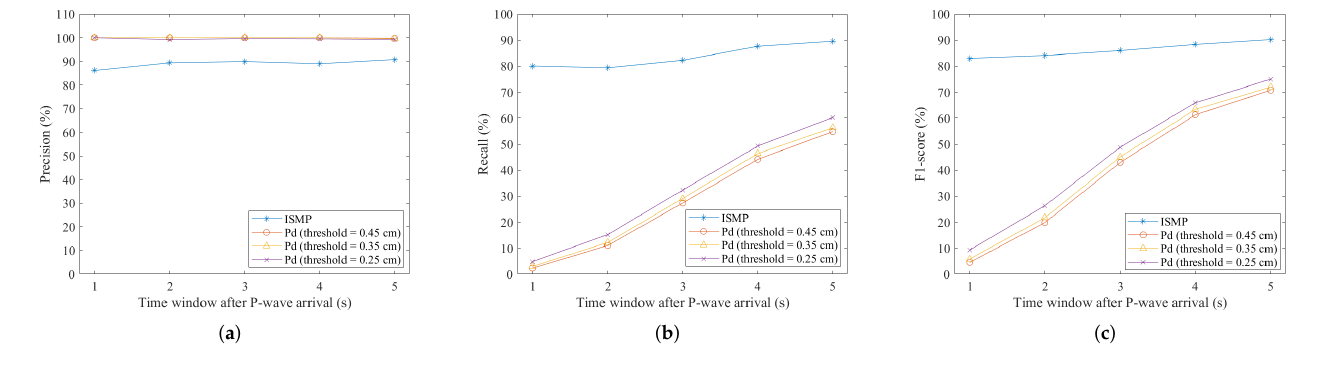
Figure 6. Accuracy measurements. ( a ) Precision. ( b ) Recall. ( c )